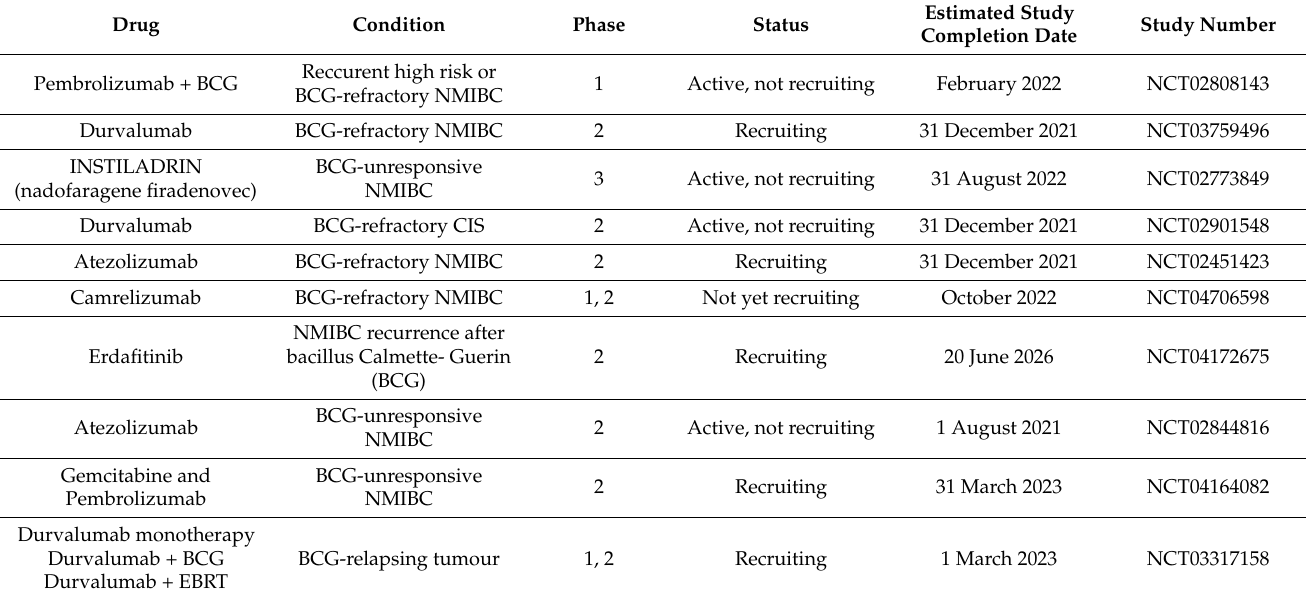
Table 1. Ongoing trials on treatment failure after intravesical BCG